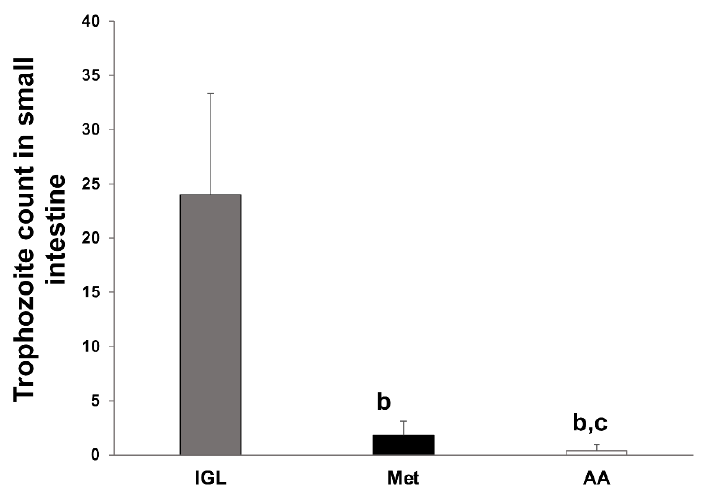
Figure 1. Treatment with A. annua reduced trophozoite counts in the small intestine of infected hamsters. Trophozoites were counted in infected untreated hamsters (IGL) and compared to counts in animals treated with metronidazole (Met) or A. annua (AA) extract. Data are expressed as mean ± SD (n = 8) and were analyzed using ANOVA with Bonferroni corrections for pairwise comparison. Letter “ b ” indicates significant reductions in trophozoite counts after treatments compared to IGL group ( p < 0.001). Letter “ c ” indicates a significant difference in trophozoite count between Met and AA group ( p < 0.001).